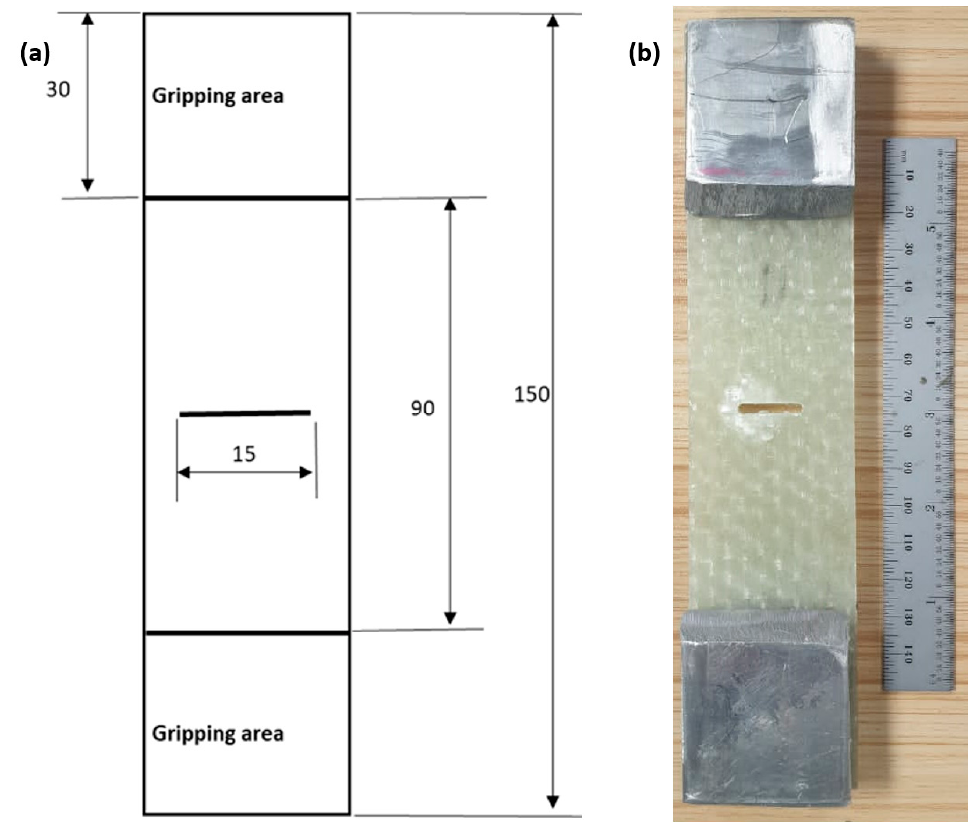
Figure 5. Centre notch tension specimen. ( a ) Schematic drawing (dim. in mm); ( b ) Real image.